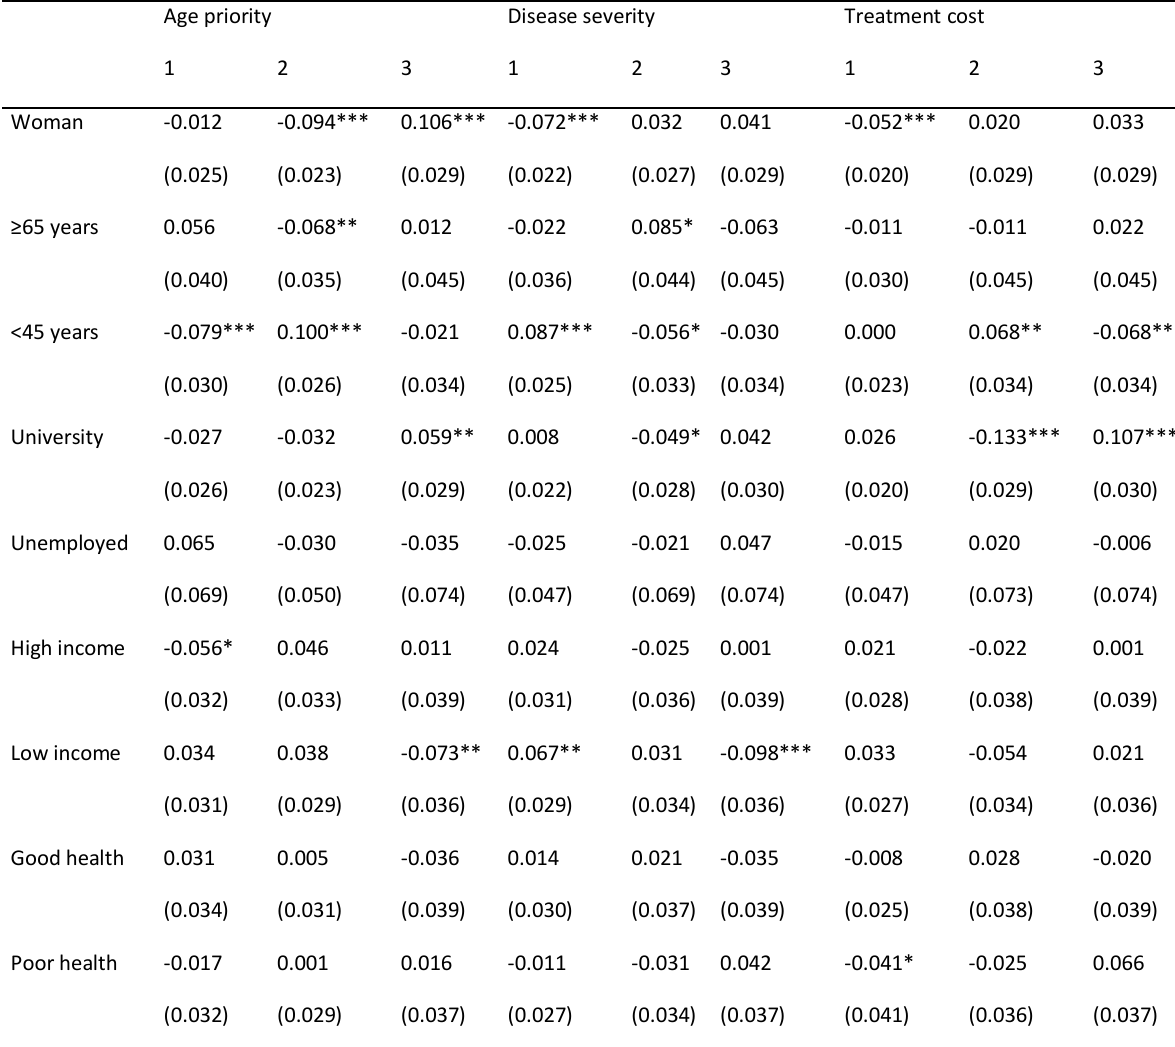
Table 3: Average marginal effects after multinomial logistic